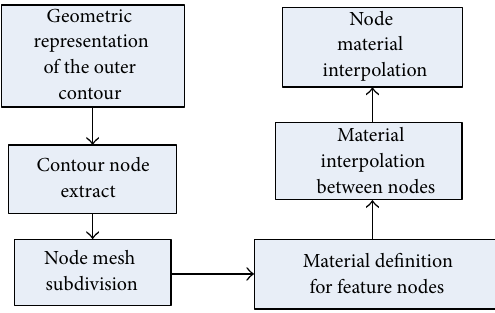
Figure 2: CAD design process models for heterogeneous